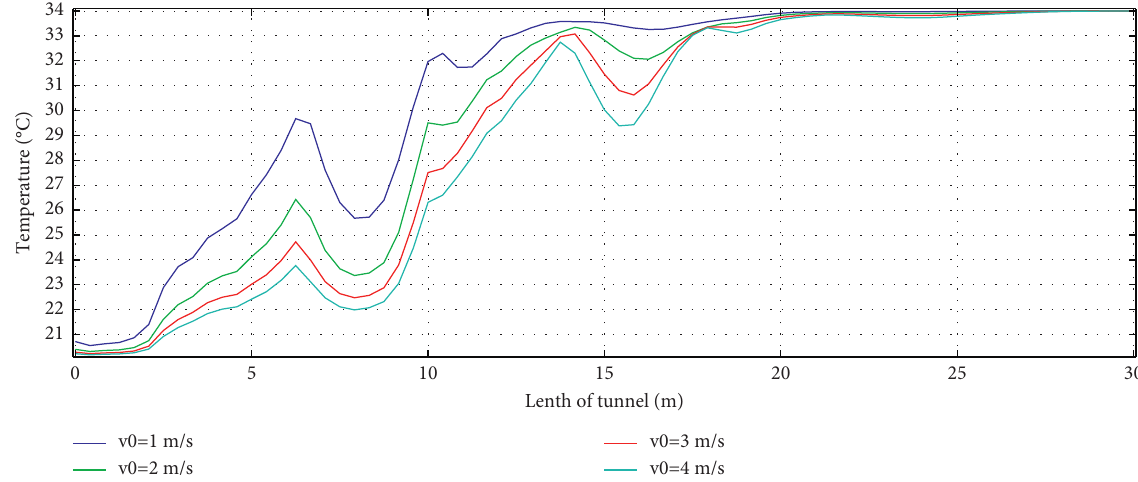
Figure 7: Temperature distribution on the wall surface at different wind